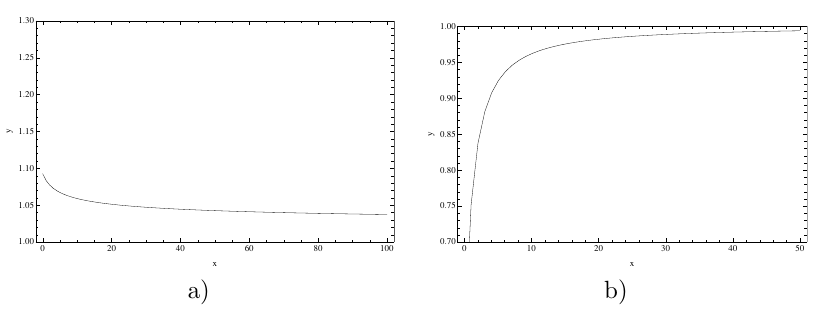
Figure 1. Plots of I α ( y ) /y asym as in Lemma 2 for y ( x ) = (1 + x β ) − 1 with a) β = 1, b) β =